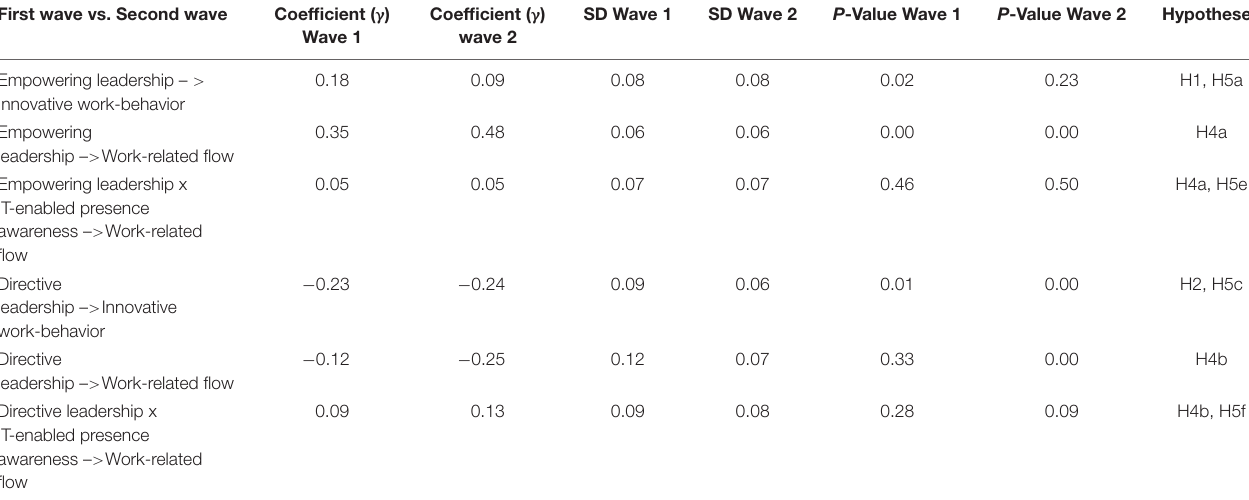
TABLE 6 | Structural direct relationships with path coefficients ( γ ) for the first wave (T1) and second wave (T2).